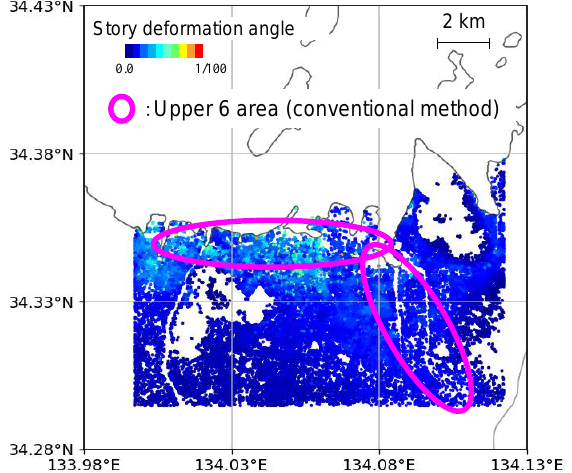
Figure 6. Distribution of maximum story deformation angle of wooden buildings.